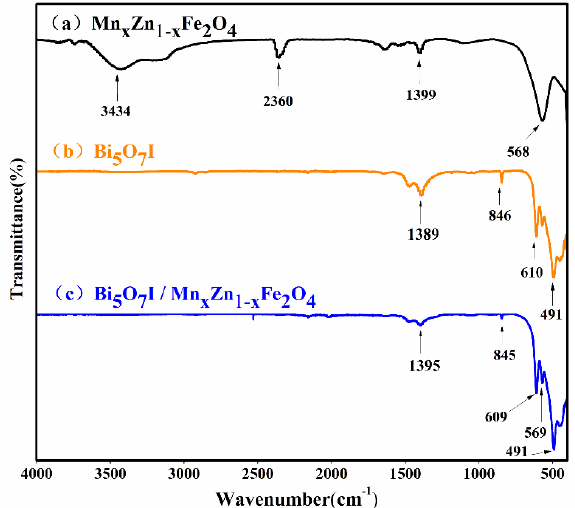
Figure 2. ( a ) Fourier-transform infrared (FTIR) spectrum of Mn x Zn 1 − x Fe 2 O 4 ; ( b ) FTIR spectrum of Bi 5 O 7 I; ( c ) FTIR spectrum of Bi 5 O 7 I/Mn x Zn 1 − x Fe 2 O 4 .